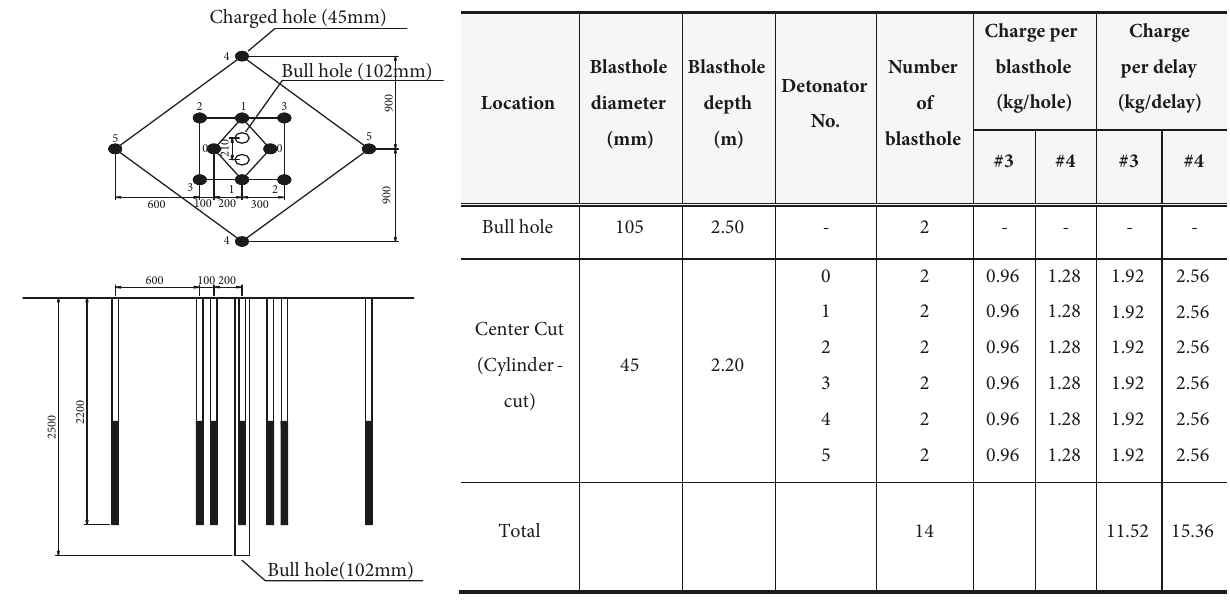
Figure 6: Blasting pattern (cylinder-cut) (Test #3, #4).